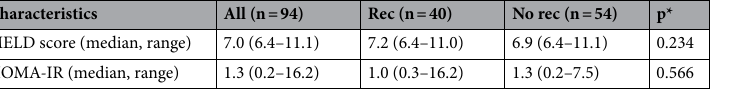
Table 1. The demographics and baseline characteristics of all enrolled patients, patients with and without tumor recurrence (rec). B hepatitis B virus, C hepatitis C virus, NBNC non-hepatitis B virus and non-hepatitis